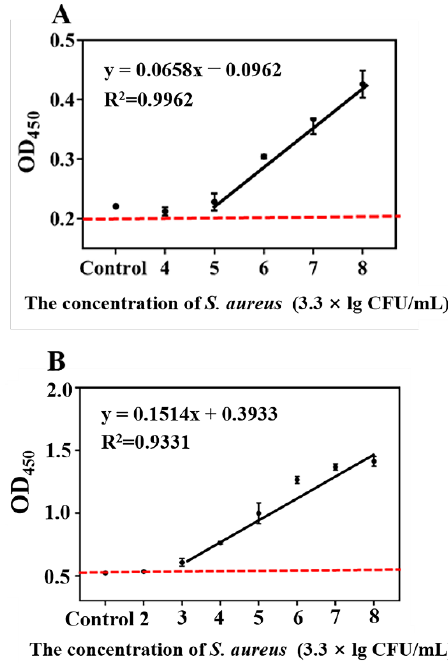
Figure 7. ( A ) The LOD and calibration curve of the common colorimetric detection method for S. aureus in juice samples. ( B ) The LOD and calibration curve of the AMS-DNFs amplification colorimetric detection method for S. aureus in juice samples.